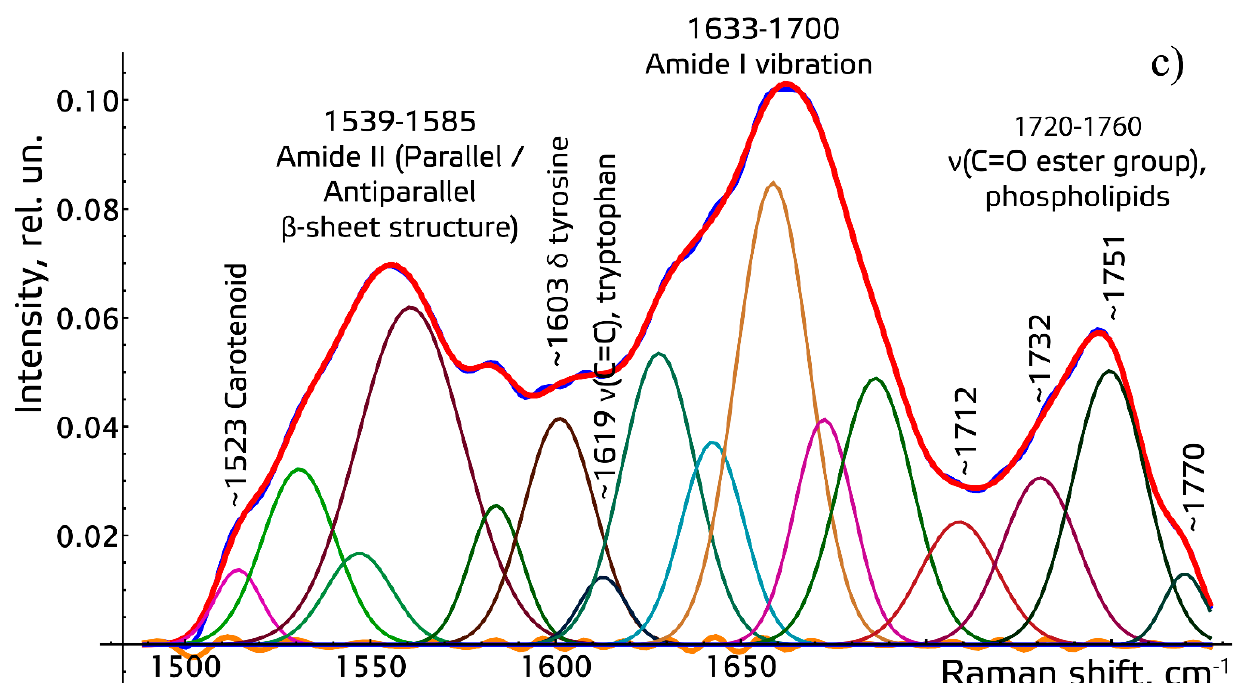
Figure 2. The example of decomposition of spectral contours of the studied dental tissues: ( а ) in the range of 508–1136 cm − 1 , ( b ) in the range of 1137–1490 cm − 1 , ( c ) in the range of 1491–1781 cm − 1.